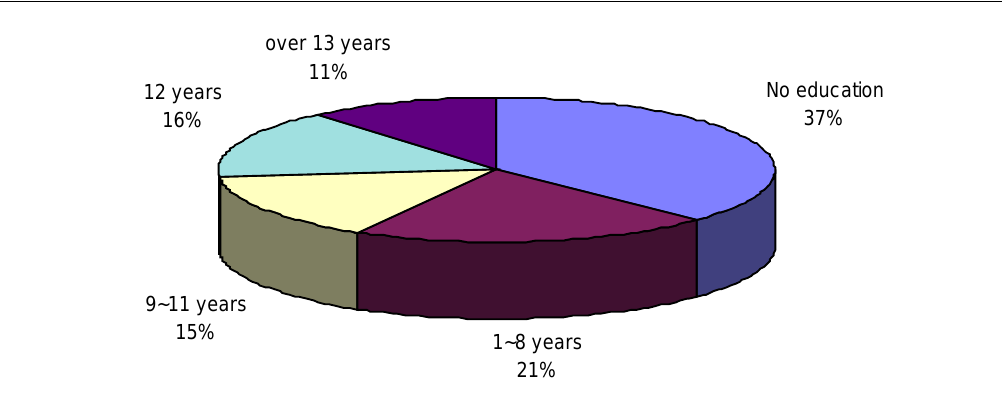
The survey results were analyzed using the SPSS statistical